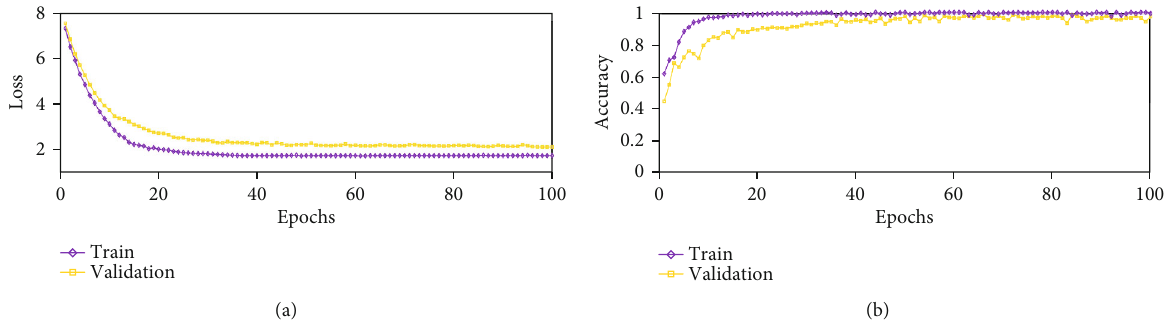
Figure 6: Comparison of model performance on the training and validation sets. (a) Loss comparison. (b) Accuracy comparison.